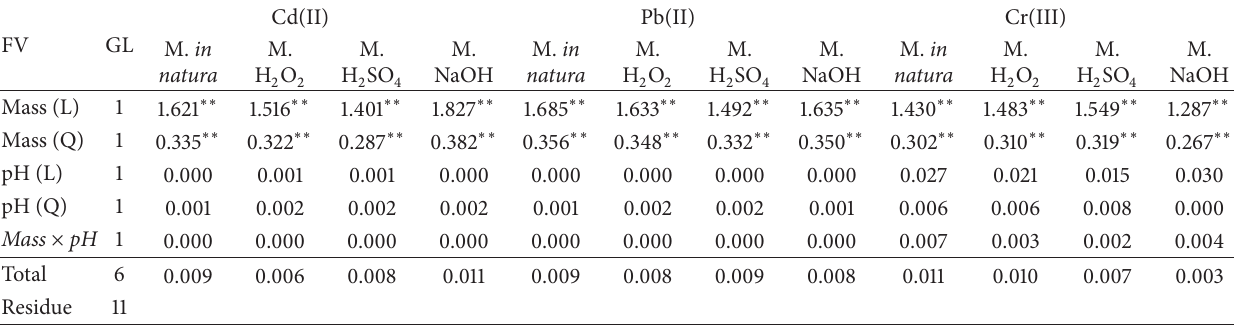
Residue 11 ∗∗ Significant at 1 % .